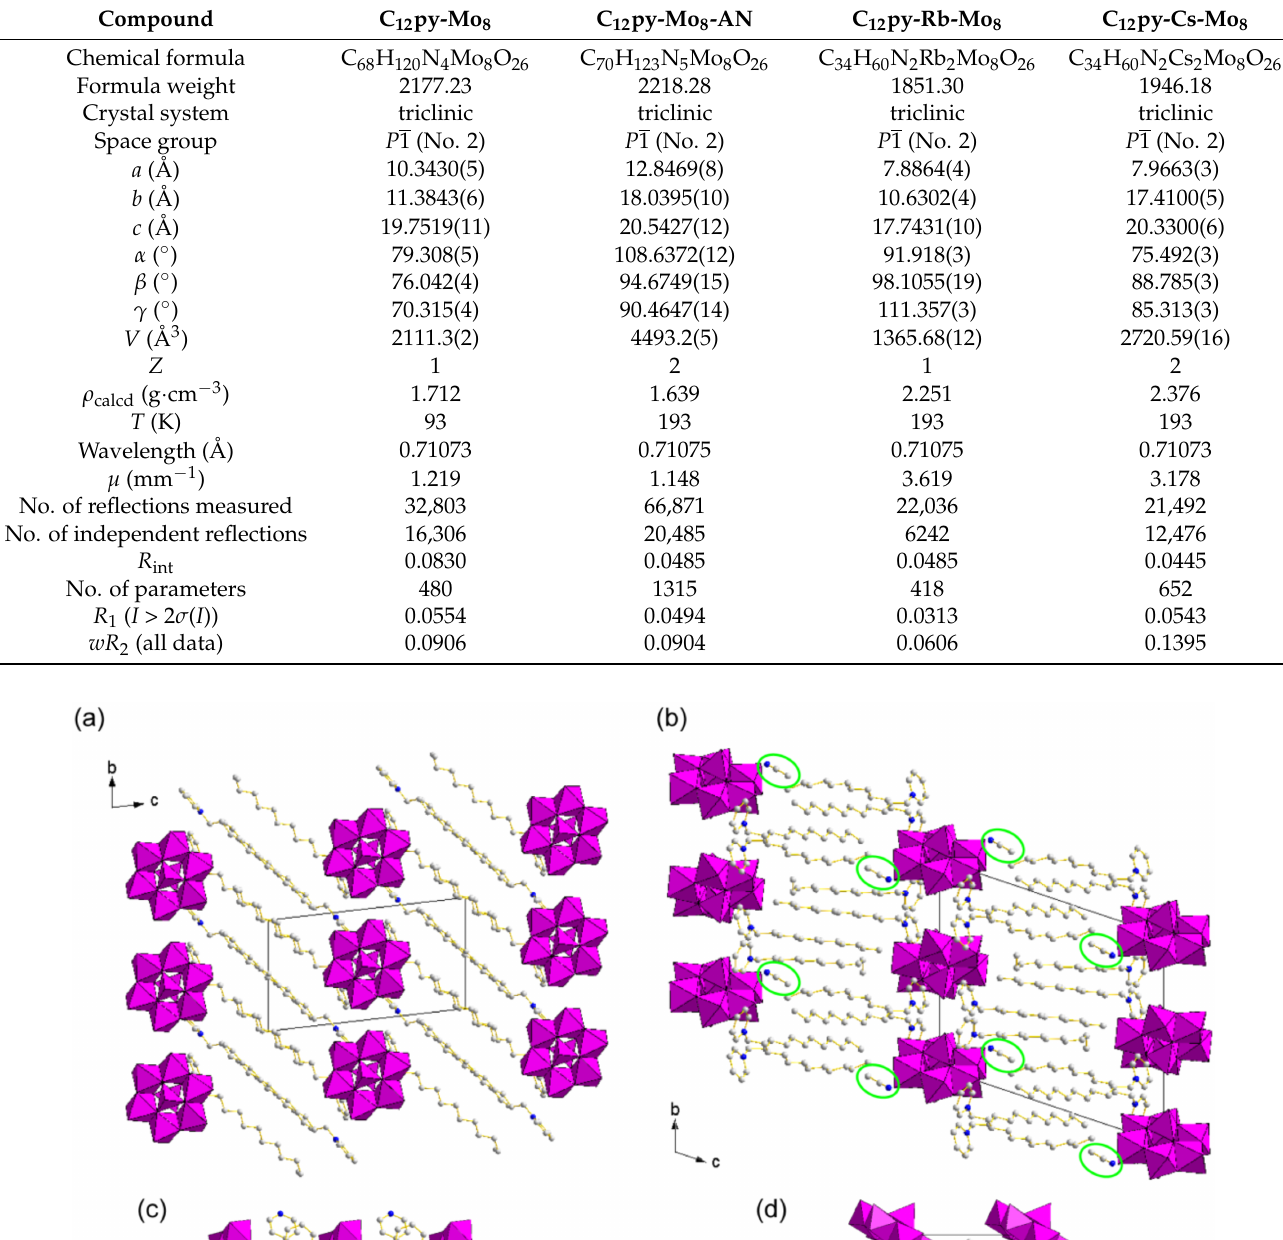
Table 1. Crystallographic data.